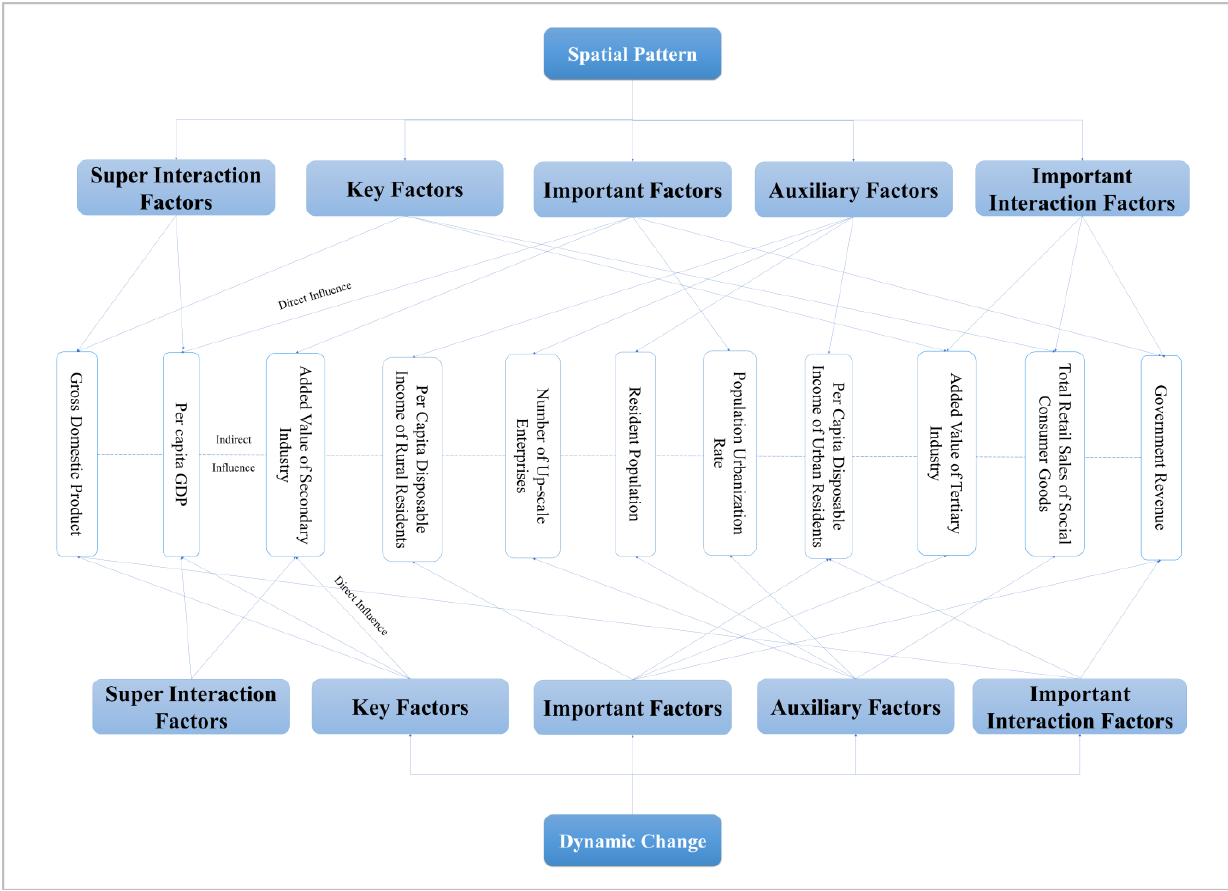
Figure 11. Driving mechanisms of urbanization in Guangxi .